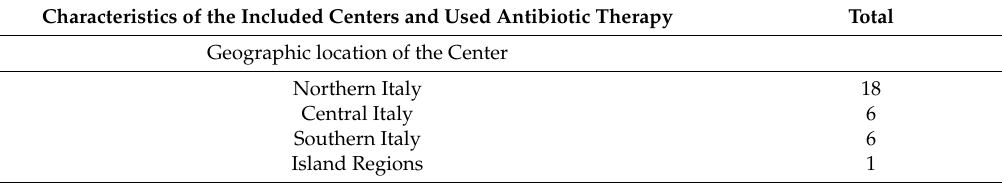
Table 1. Summary of answers to the survey by the 31 participating